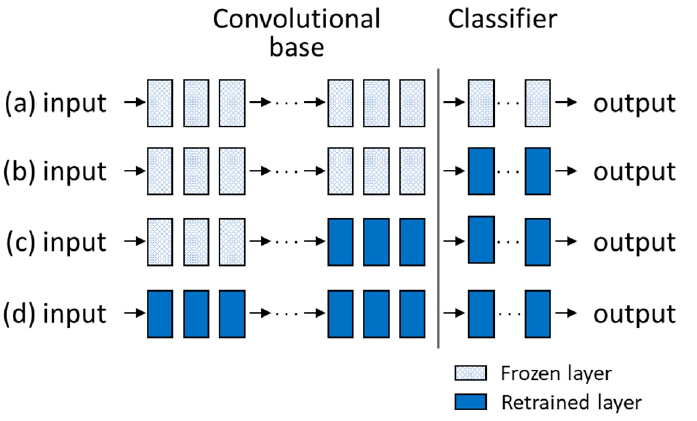
Figure 4. Different usages of pre-trained model: ( a ) Freeze the whole model. ( b ) Freeze the convolu- tional base and train the classifier. ( c ) Train most of the convolutional base layers and the classifier. ( d ) Train the whole model.